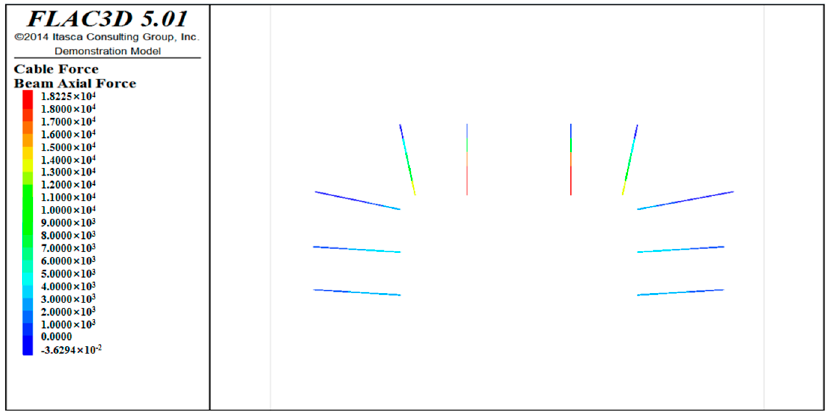
Figure 10. Distribution of plastic zone.